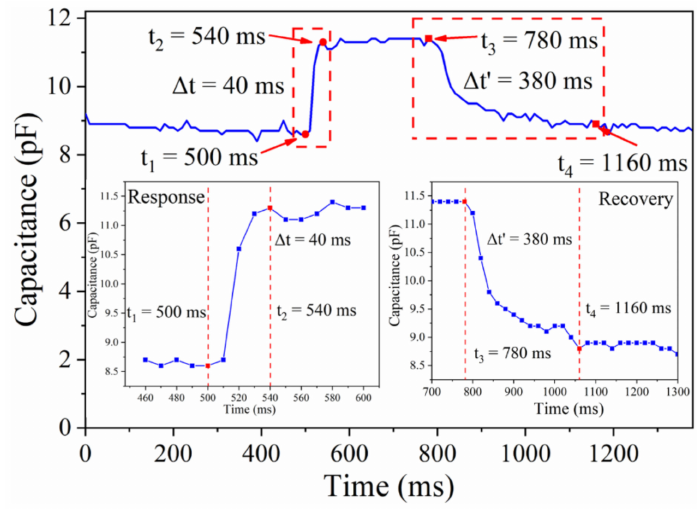
Figure 8. Response and recovery time of pressure sensor.